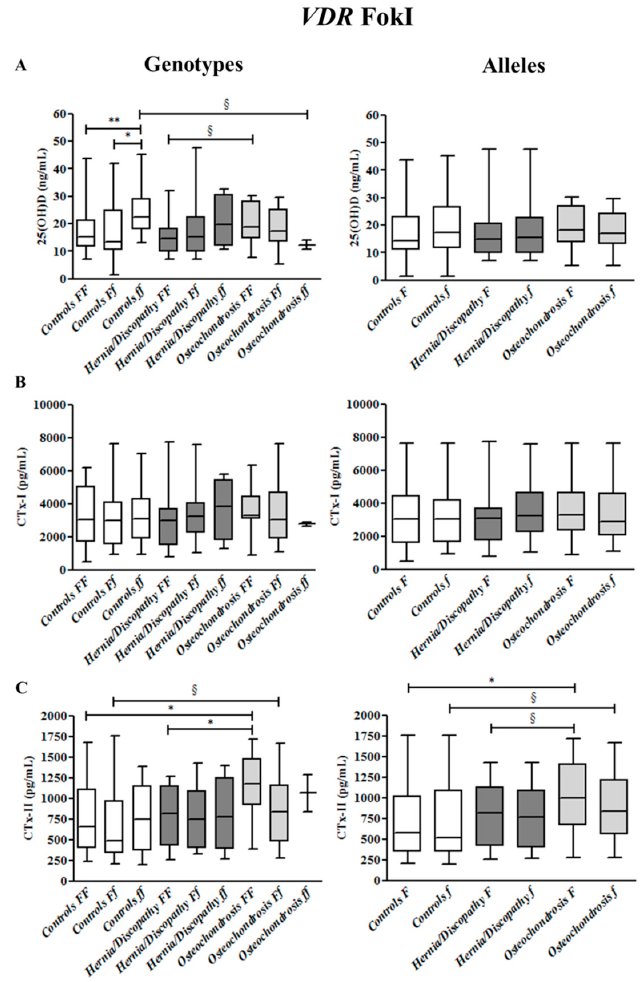
Figure 1. 25hydroxyvitamin D (25(OH)D) ( A ), cross-linked C-telopeptides of type I collagen (CTx-I) ( B ), and cross-linked C-telopeptides of type II collagen (CTx-II) ( C ) plasma concentrations in controls and in the subgroups of patients with hernia/discopathy and osteochondrosis, distributed according to FokI VDR genotypes/alleles. The box and whisker plots show the median, 25th, and 75th percentile (interquartile) (the box), and minimum and maximum value (the whiskers). * p < 0.05. ** p < 0.01. § indicates a tendency.